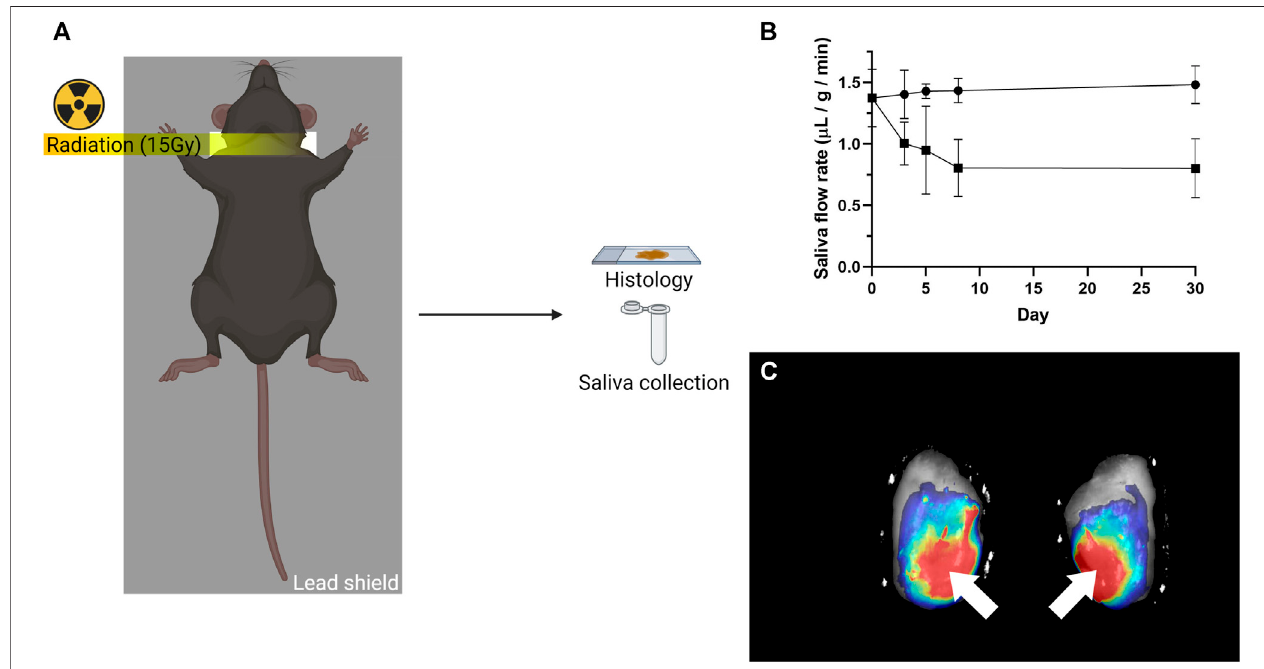
FIGURE1| Radiationtreatment andlocalL 1P -FHdeliveryusedinthisstudy. (A) Micereceivedasingle15 Gyradiationdosewithacustomizedleadshieldhavinga 1 cm slit aligned to the mouse ’ s neck. (B) Radiation treatment caused saliva fl ow rates to be signi fi cantly reduced. The symbol ( the symbol ( ■ ) indicates irradiated group. (C) DyLight 680 conjugated L 1P -FH were successfully delivered to the mouse submandibular glands when applied via transdermal injection. White arrows indicate the site of L 1p -FH